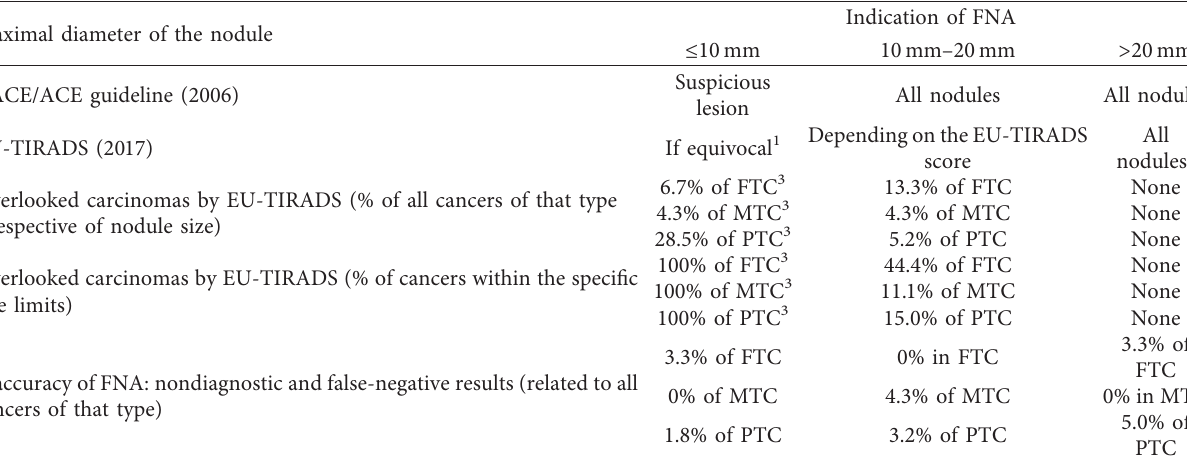
Table 2: Evaluation of nodular goiter based on the 2006 Guideline of the AACE/ACE and on the EU-TIRADS in relation to missing the cancer diagnosis in three subtypes of thyroid cancers.